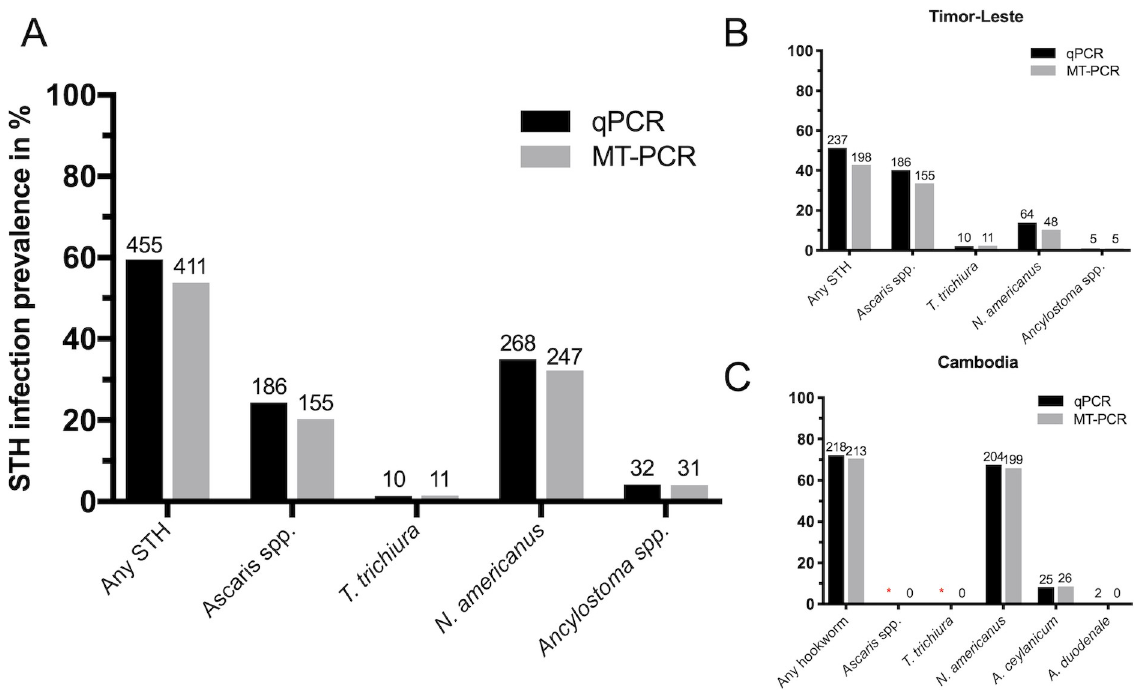
Fig 1. Overall infection prevalence of the major STH species comparing multiplexed qPCR and MT-PCR diagnostic approaches in cohorts from Timor-Leste (B) Cambodia (C) and combined (A). (A) Representation of combined infection prevalence for Timor-Leste and Cambodian cohort in percent with total numbers of positive infections as seen on individual bars. (B) Estimation of infection prevalence in Timor-Leste cohort of 462 stool samples with percentage infection prevalence on y-axis and STH species by diagnostic method on x-axis. (C) Estimation of infection prevalence in Cambodian cohort of 302 stool samples with percentage infection prevalence on y-axis and STH species by diagnostic method on x-axis. Estimation of infection by qPCR has been conducted for hookworm infections only. Field study setting is known to show very little to no A . lumbricoides or T . trichuris infections as to why these infections have not been included in estimation of infection prevalence by qPCR with confirmation of zero positive infections by MT-PCR within the scope of this study ( � ).